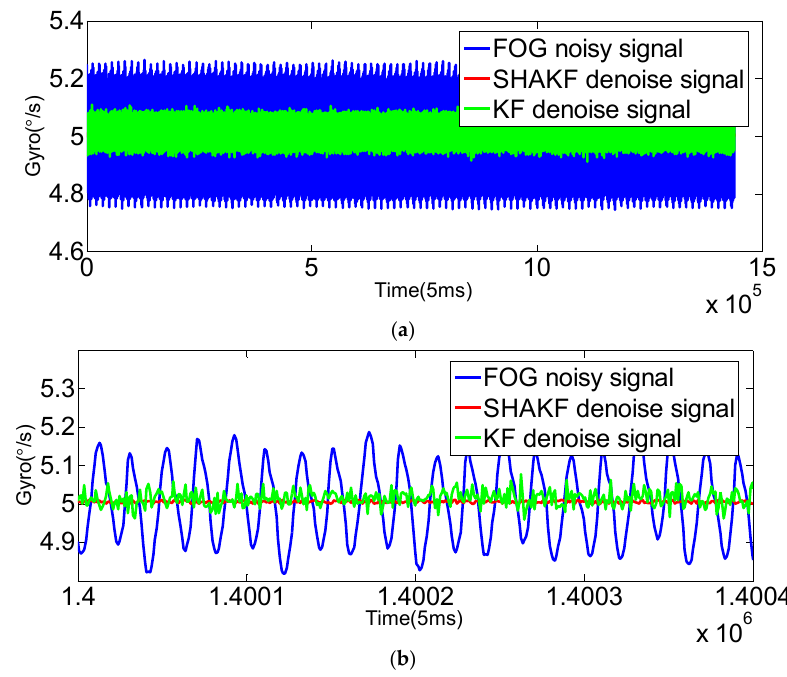
Figure 10. Comparison of the results before and after denoising for the FOG dynamic signal at a rate of 5°/s. ( a ) Denoising the results of the FOG dynamic signal ( x -axis) for 2 h; ( b ) local enlarged graphs. Sensors 2016 , 16 , 1073